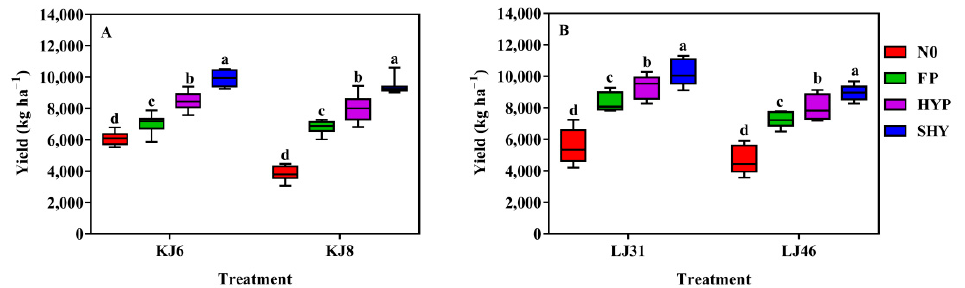
Figure 2. Yield of different cultivars in different sites (( A ) in Daqing; ( B ) in Suiling) and under different cultivation patterns (N0, FP, HYP, and SHY). KJ: Kenjing 6; KJ8: Kenjing 8; LJ31: Longjing 31; LJ46: Longjing 46; N0: no nitrogen application; FP: local farmer practice; HYP: high-yield, high- efficiency practice; SHY: super-high-yield practice. Bars are mean ± SE ( n = 3), different letters indicate statistical significance at the p < 0.05 level under different treatments.